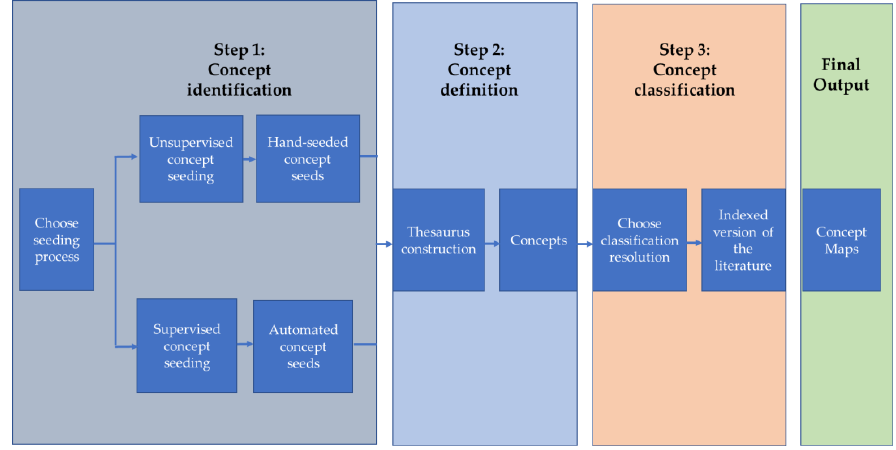
Figure 6. Workflow of the stages of the automated content analysis. (Source: our elaboration.)